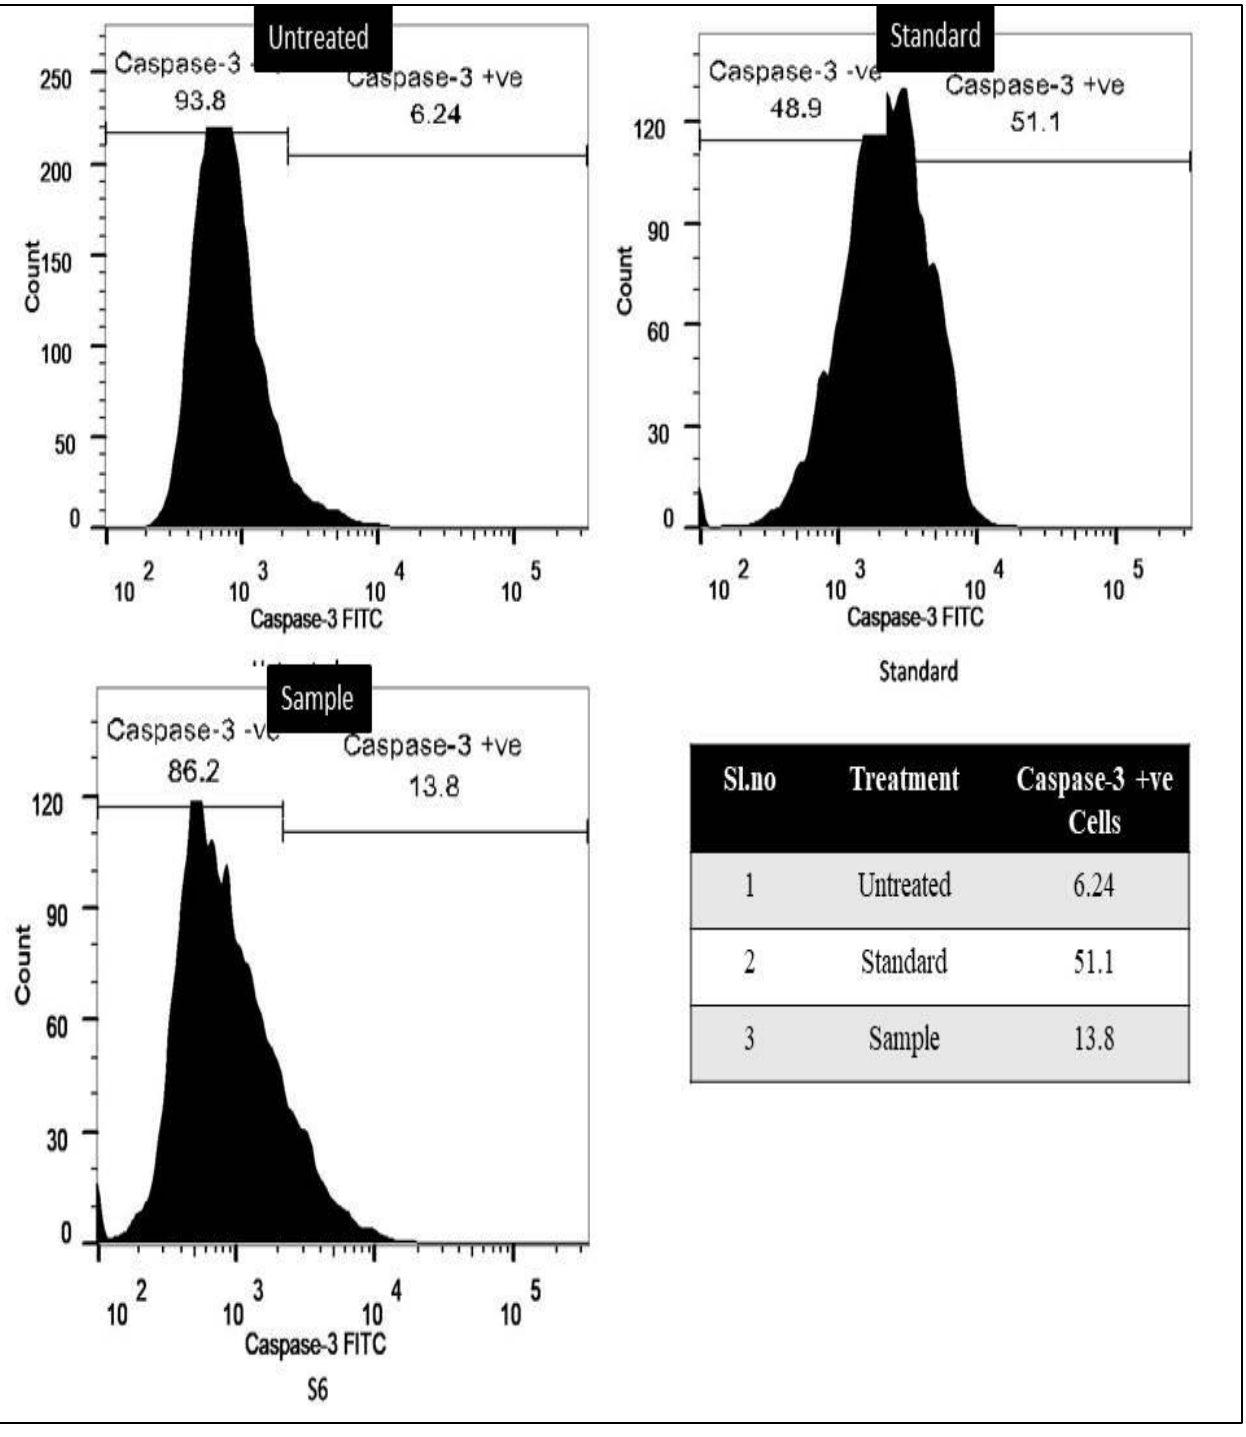
Figure 4. Confirmation of apoptosis induced by methanol extract of C. colocynthis in the breast cancer MCF-7 cell line through caspase-3 assay.